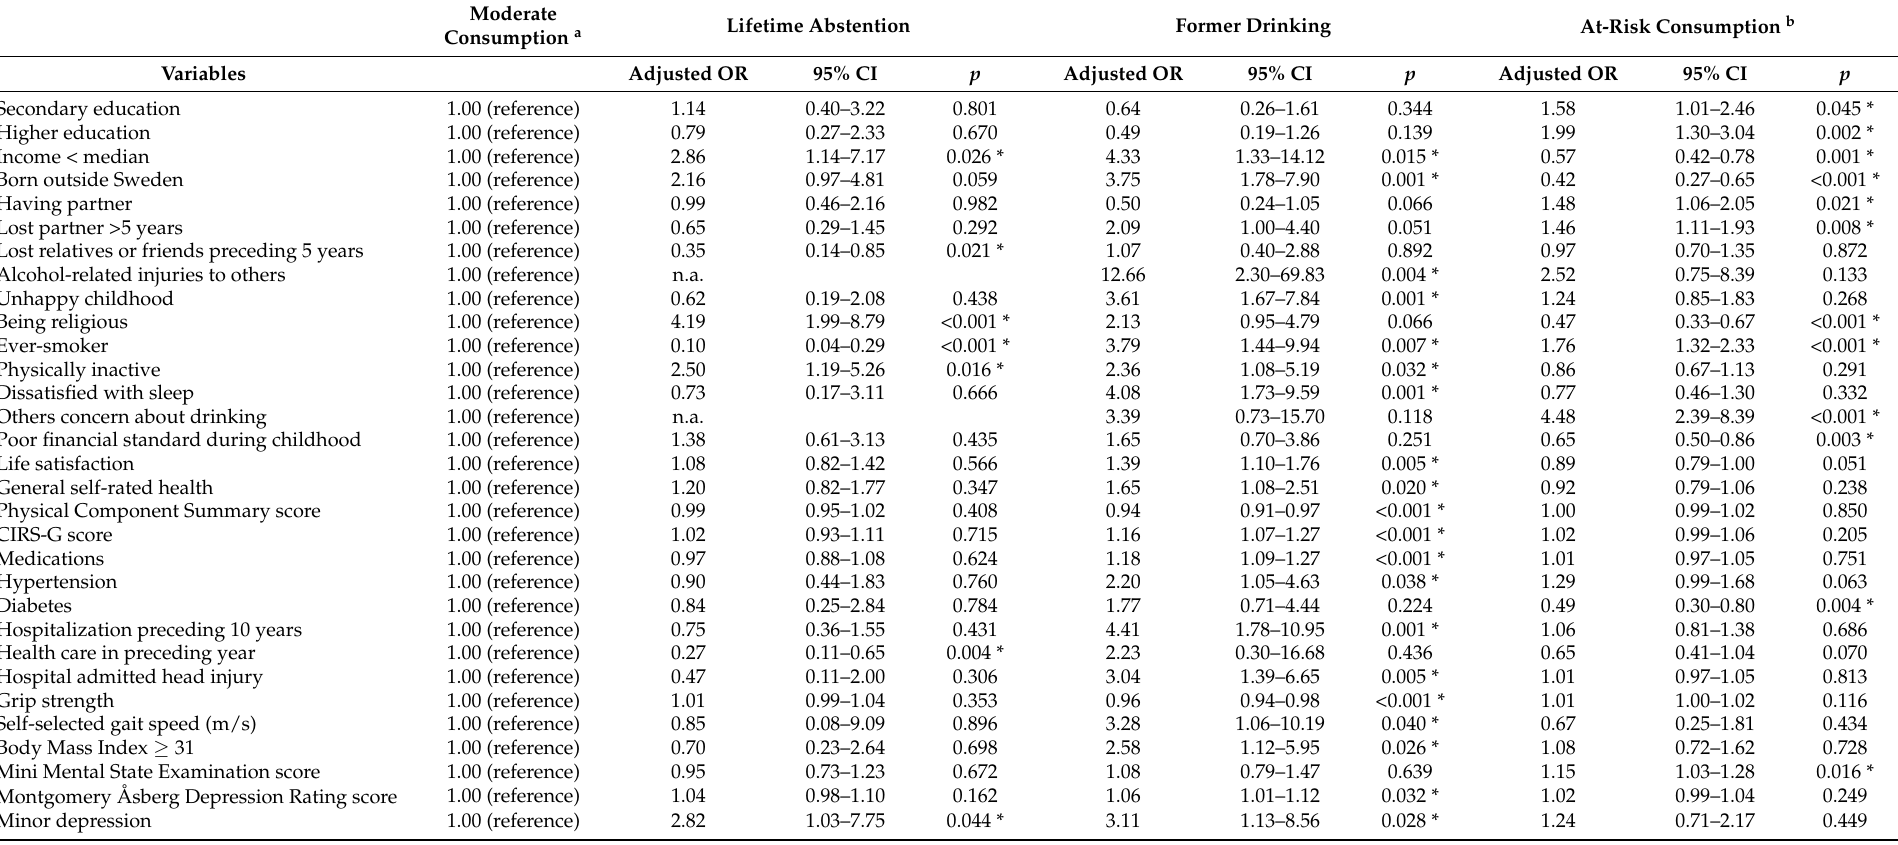
Table 4. Sociodemographic, social, and health-related factors associated with lifetime abstention, former drinking and at-risk consumption. Moderate Lifetime Abstention At-Risk Consumption Consumption a